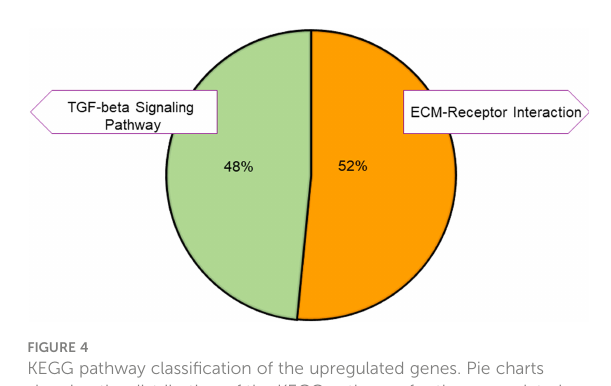
FIGURE 4 KEGG pathway classi fi cation of the upregulated genes. Pie charts showing the distribution of the KEGG pathways for the upregulated genes. The pathways were obtained by using DAVID. Different colors represent different pathways, and the percentage numbers represent the fold enrichment of the genes associated with that